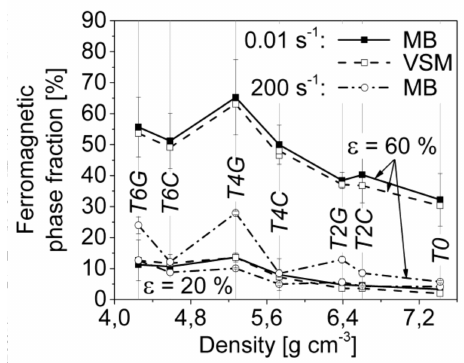
Figure 13. Ferromagnetic phase fraction of the different TRIP-steel syntactic foams and the matrix reference material at 20% and 60% compressive strain with respect to strain rate (0.01 s − 1 , 200 s − 1 ) and density, measured by magnetic balance (MB) and VSM measurements.